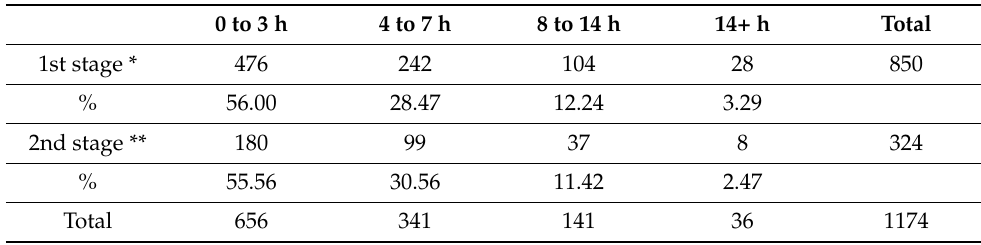
Table 6. Pupils’ responses to the question “How many hours a week do you watch television?” before and after situation caused by COVID-19. 0 to 3